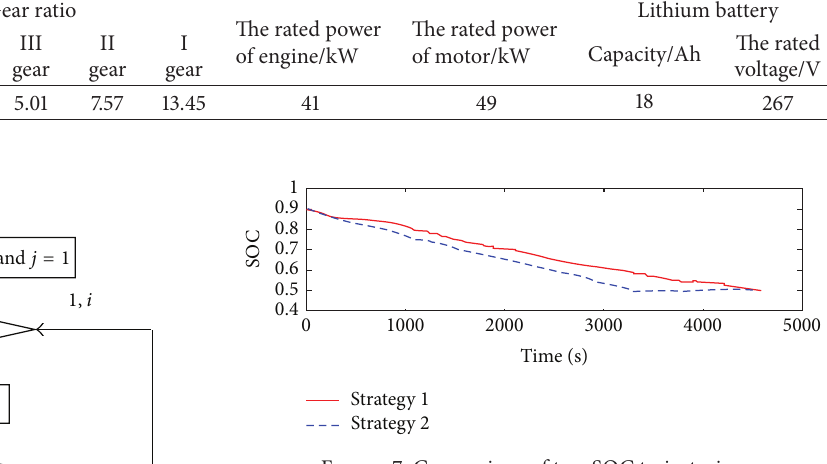
Figure 7: Comparison of two SOC trajectories.